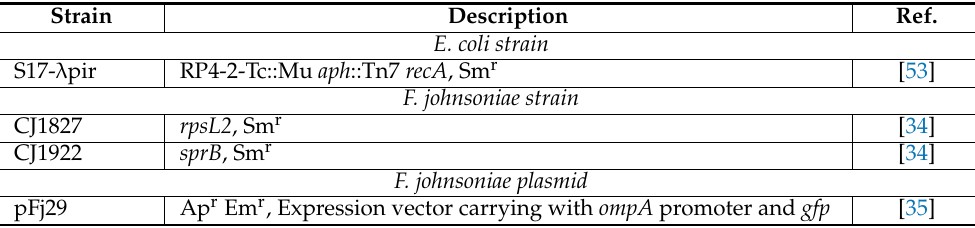
Table 1. Bacterial strains and plasmids used in this study. Strain Description